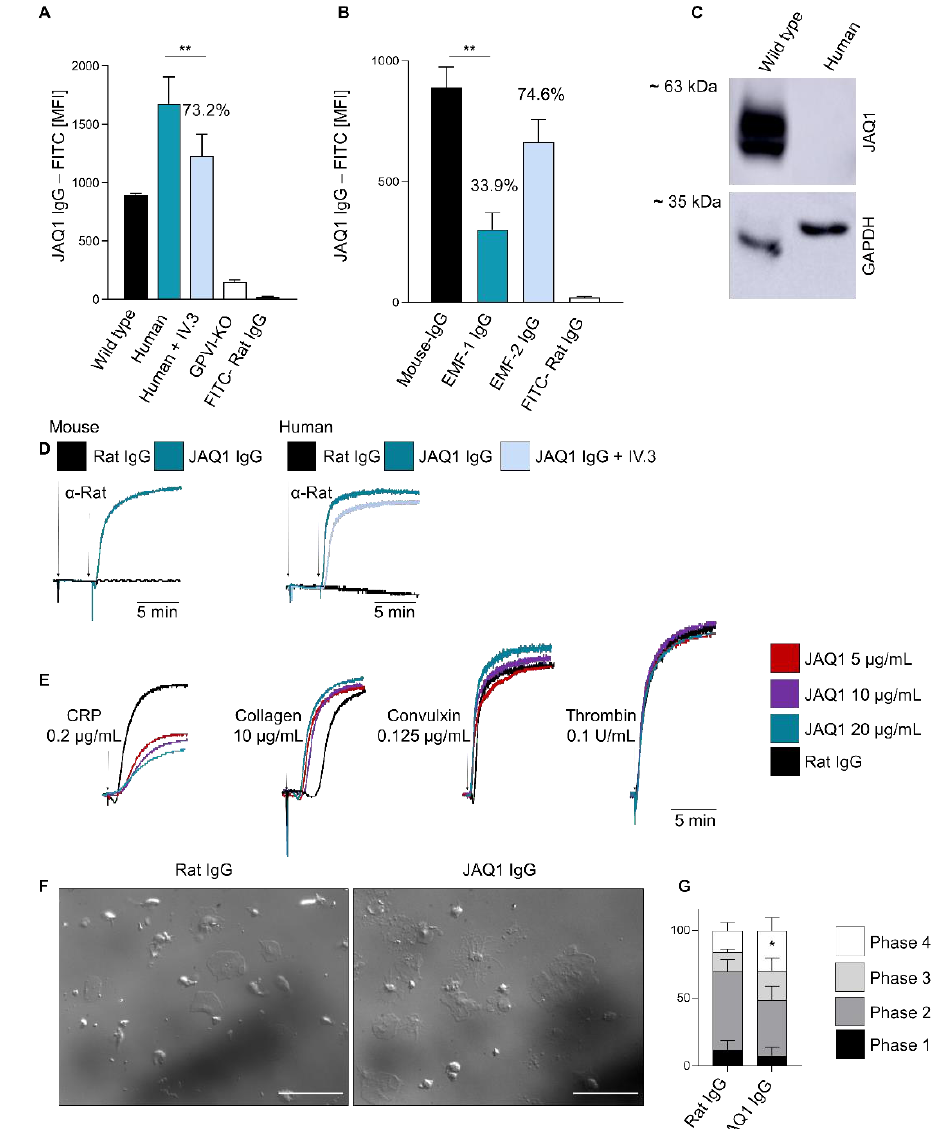
Figure 1. Anti-mouse GPVI monoclonal antibody JAQ1 binds to human GPVI and modulates its function. ( A ) Washed human or mouse blood was pre-incubated with JAQ1 IgG-FITC and Mean Fluorescence Intensity (MFI) was measured by flow cytometry; where indicated, human blood was pre-incubated with 20 µ g/mL IV.3. Irrelevant rat-IgG-FITC was used as control; ( B ) Human blood was pre-incubated with 20 µ g/mL EMF1, EMF-2 or control IgG for 10 min and subsequently incubated with JAQ1-FITC for 10 min, irrelevant IgG-FITC was used as control; ( C ) Mouse ( WT ) and human platelet lysates were separated by 10% SDS-PAGE under non-reducing condition and blotted onto PVDF membrane. JAQ1-HRP was used to detect GPVI on the membrane. GAPDH served as loading control; ( D ) Murine or human washed platelets were pre-incubated with either JAQ1 or a control IgG and aggregometry was performed; crosslinking of bound antibody was induced by adding an anti- Rat IgG antibody and light transmission was recorded for 15 min. When indicated, human platelets were incubated with IV.3 prior to JAQ1 addition; ( E ) Human washed platelets were pre-incubated with either JAQ1 or a control IgG and aggregometry was performed; aggregation was induced using the indicated agonists and for 10 min; ( F , G ) Human-washed platelets were pre-incubated with IV.3 plus JAQ1 IgG or a control IgG and let spread on a 100 µ g/mL fibrinogen-coated surface for 45 min at 37 ◦ C. Experiments shown are representative of n = 4. Flow cytometry and spreading data are expressed as mean ± SD, significance is expressed as * p < 0.05, ** p < 0.01, vs. indicated group ( t